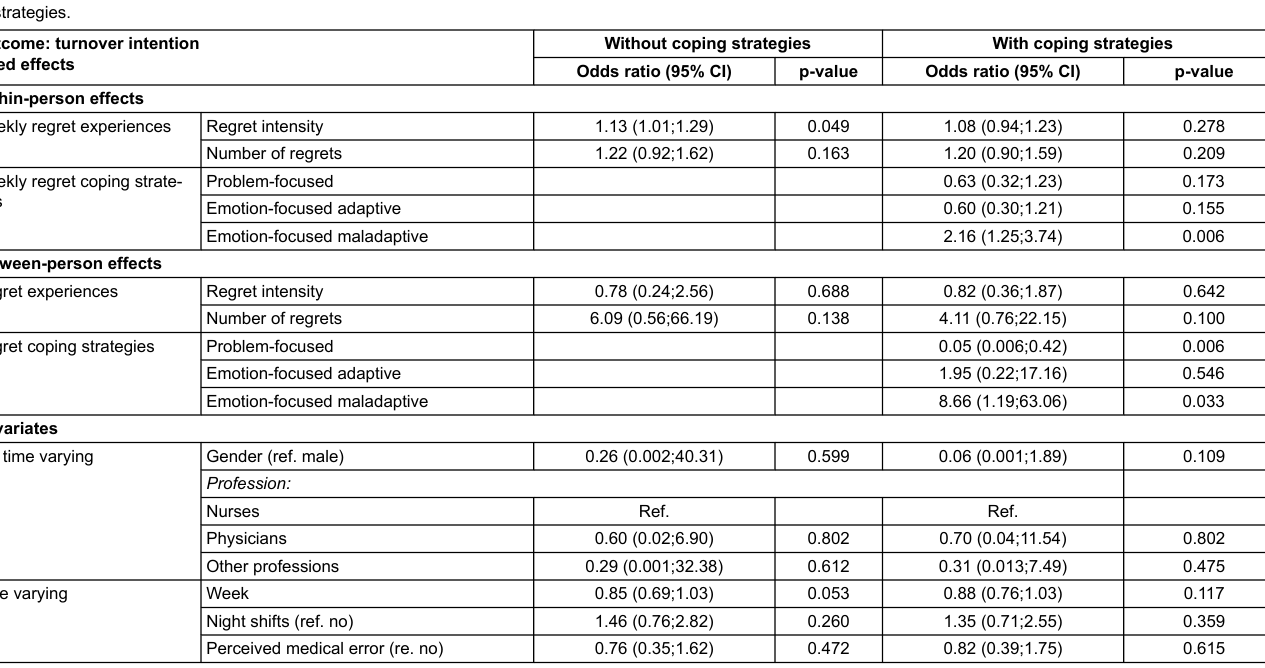
Figure 2: Descriptive results showing the association between re- gret intensity (A) and number of regrets (B) and intention turnover.